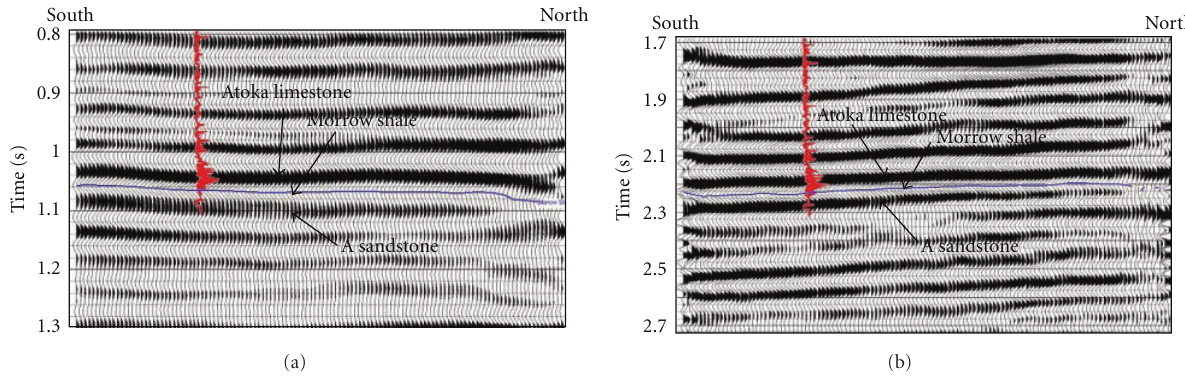
Figure 18: The above sections are (a) P-wave stack and (b) S1-wave stack along an inline passing through the well used for modeling study. The Morrow A sandstone peak interferes with the side lobe of shale to give a peak doublet in P-wave stack. The S1-wave stack has a distinct Morrow A sandstone peak response. The S1-wave stack also shows some high amplitude sand layers below Morrow A which are not clearly evident in P-wave